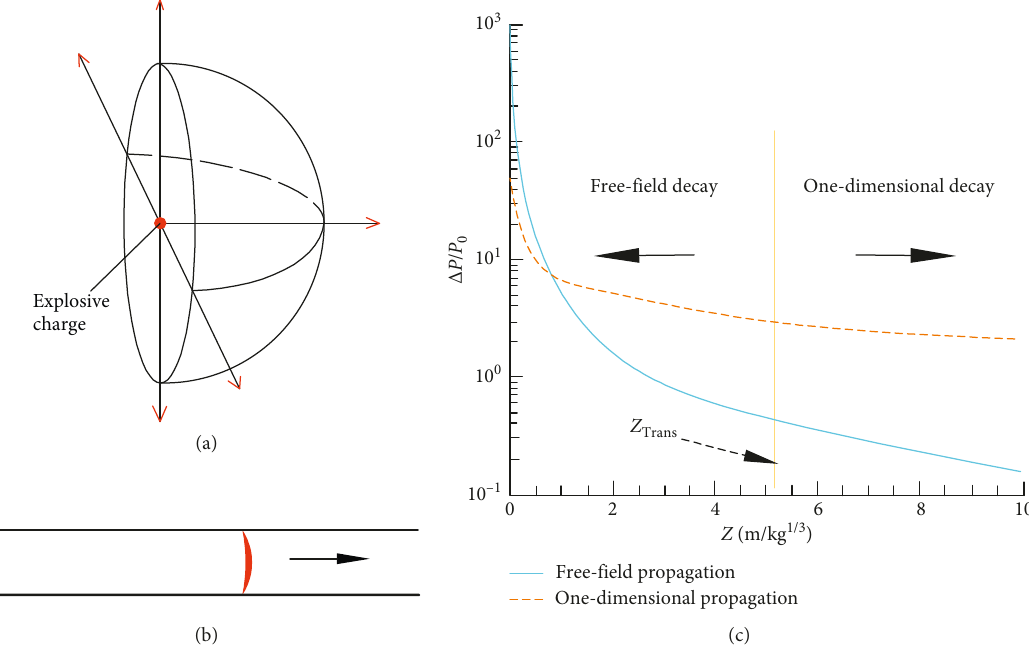
Figure 1: Blast wave propagation in a tunnel: (a) propagation near the face, (b) propagation far away from the face, and (c) the decay of overpressure along the tunnel [24,